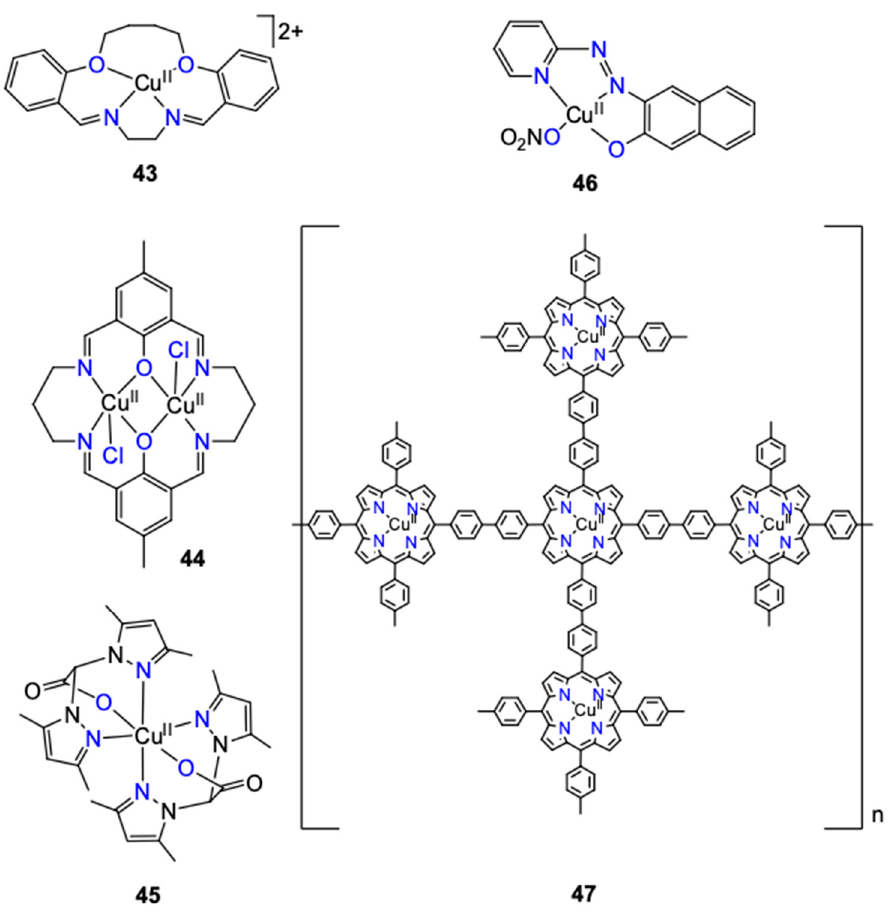
Figure 26. Precursor complexes with versatile structures.